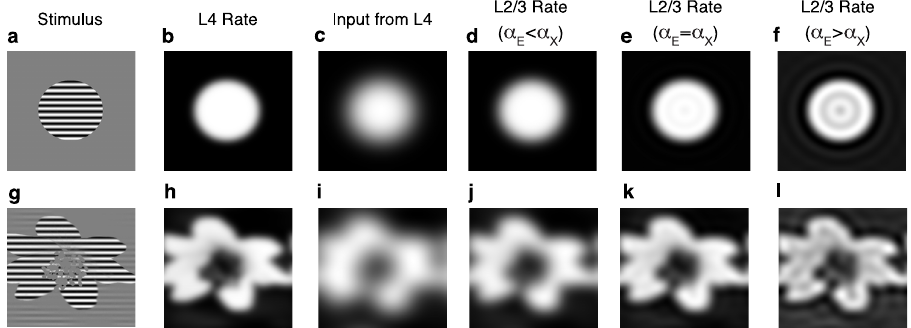
Fig 7. Imbalanced amplification and suppression reverse the blurring introduced by interlaminar synaptic divergence. a) A disc-shaped grating stimulus gives rise to b) a disc-shaped firing rate profile, r X ( x ), in L4 with slightly blurred edges (achieved by convolving contrast from a with a Gaussian kernel). c) Input, X ( x ), from L4 to excitatory E neurons in L2/3 is blurred by synaptic divergence, which effectively applies a low-pass filter, W , to the L4 rates. d) X Excitatory firing rates in L2/3 are sharper than external input when lateral excitation is similar, but smaller, in width than interlaminar excitation ( α E = 0.85 α X ). e) Same as c, but lateral excitation is exactly as broad as interlaminar excitation ( α = α ), which sharpens the edges further, making firing rates in L2/3 similar to those in L4. f) Same as c, E X but lateral excitation is broader than interlaminar excitation ( α = 1.1 α ), which sharpens the edges even further, but E X also introduced suppressed regions due to Gibbs phenomena. g-l) Same as a-f, but contrast was determined by the brightness of a photograph. Horizontal and vertical axes are neurons’ receptive